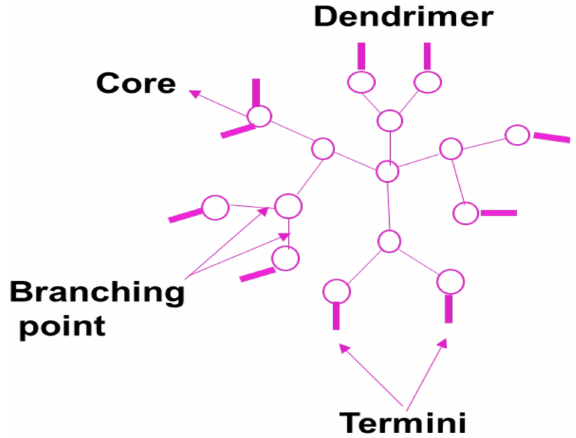
Figure 9. A schematic diagram of a